Question: Judging by this figure, is the value going up or going down?
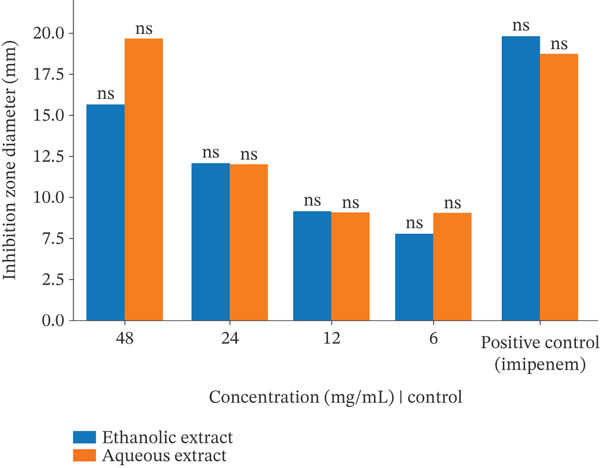
Answer: increasing